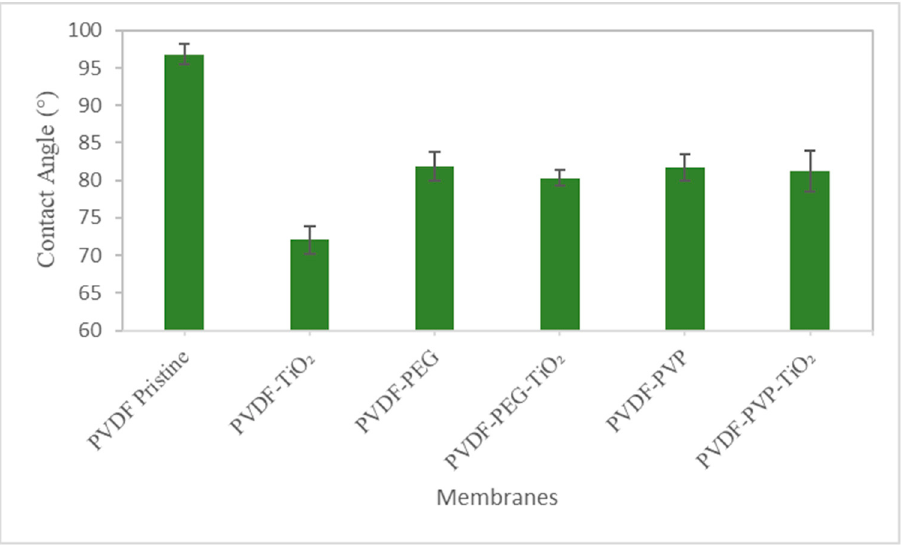
Figure 5. Contact angle of membranes.